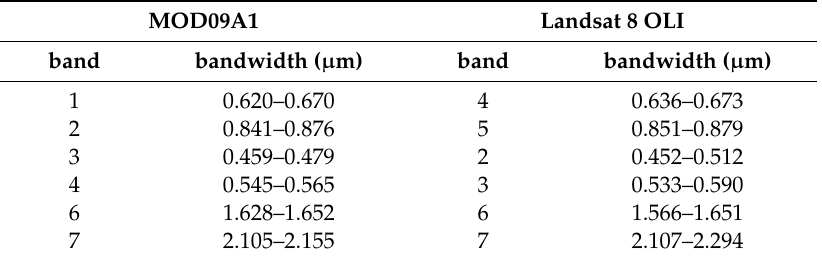
Table 5. The relationship between MOD09A1 band and corresponding Landsat 8 OLI